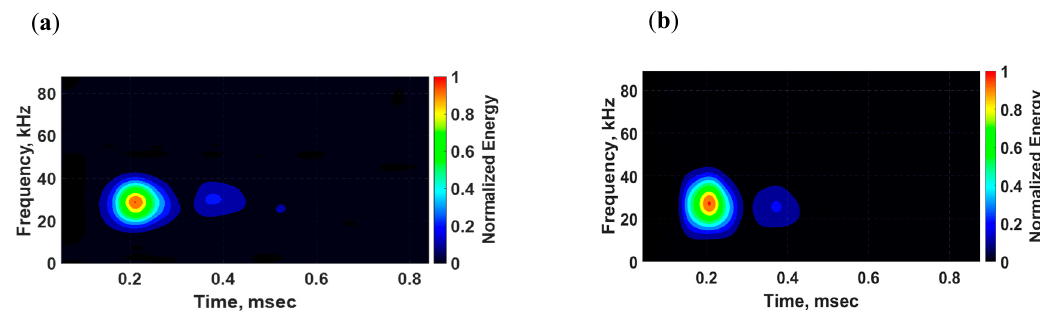
Figure 7. Time-frequency spectrums of voltage signals sensed by d35 PZT transducers embedded in the bondline of the laminate structure: ( a ) Experiment; and ( b ) simulation.